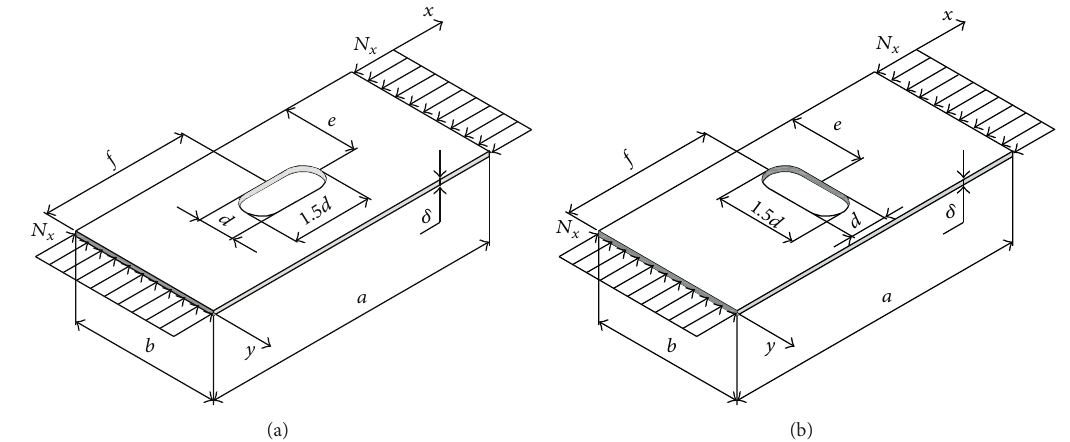
Figure 9: A rectangular plate with a slotted hole (a) horizontal (b) vertical orientation.